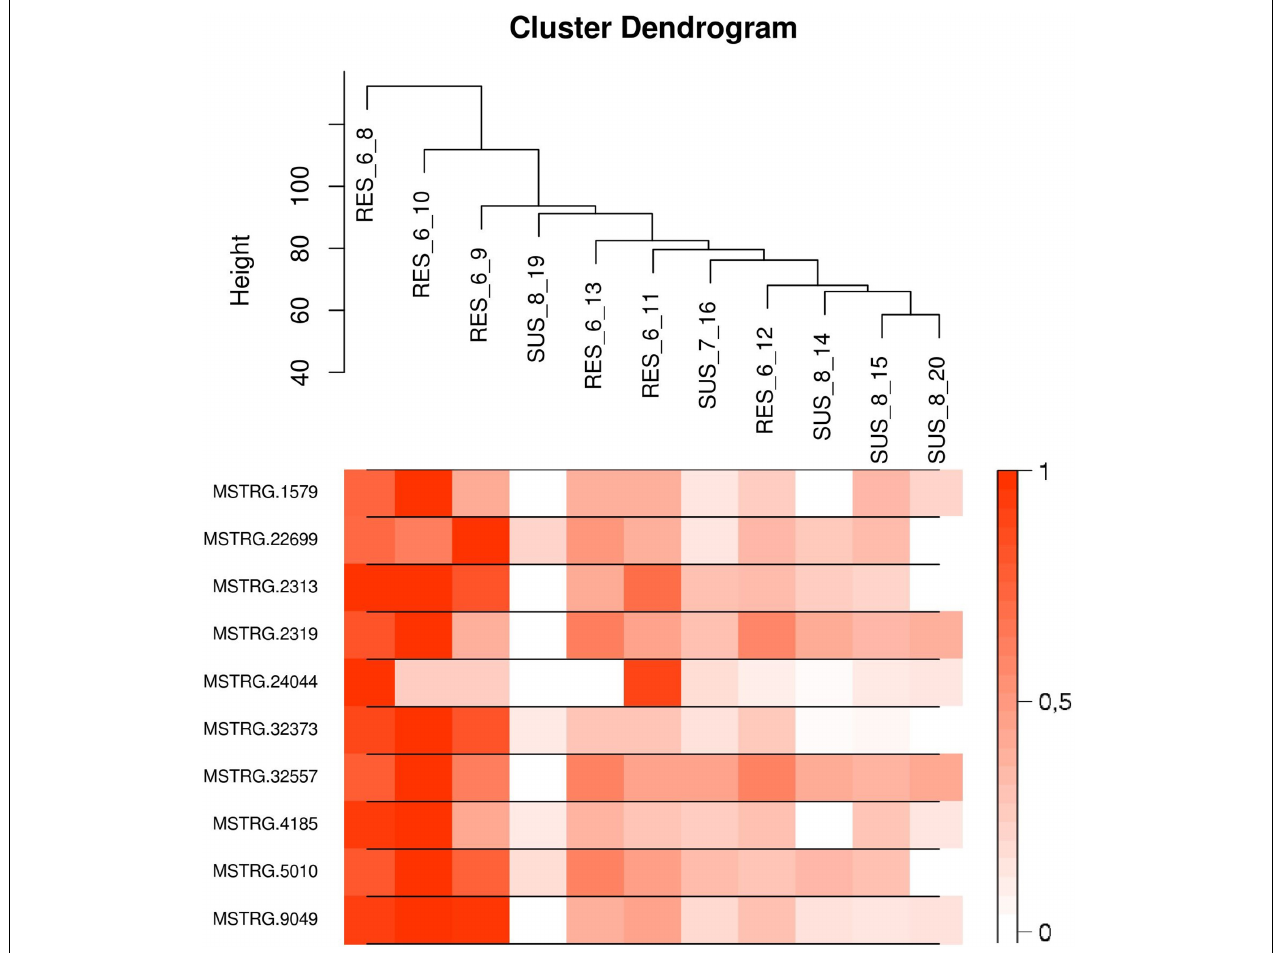
FIGURE 4 | (Top) Cluster dendrogram plot of the ALN RNA-seq data to differentiate the resistant and susceptible sheep. (Bottom) Corresponding heatmap with the expression levels from the 10 selected lncRNAs showing a notable expression differentiation in resistant compared to susceptible